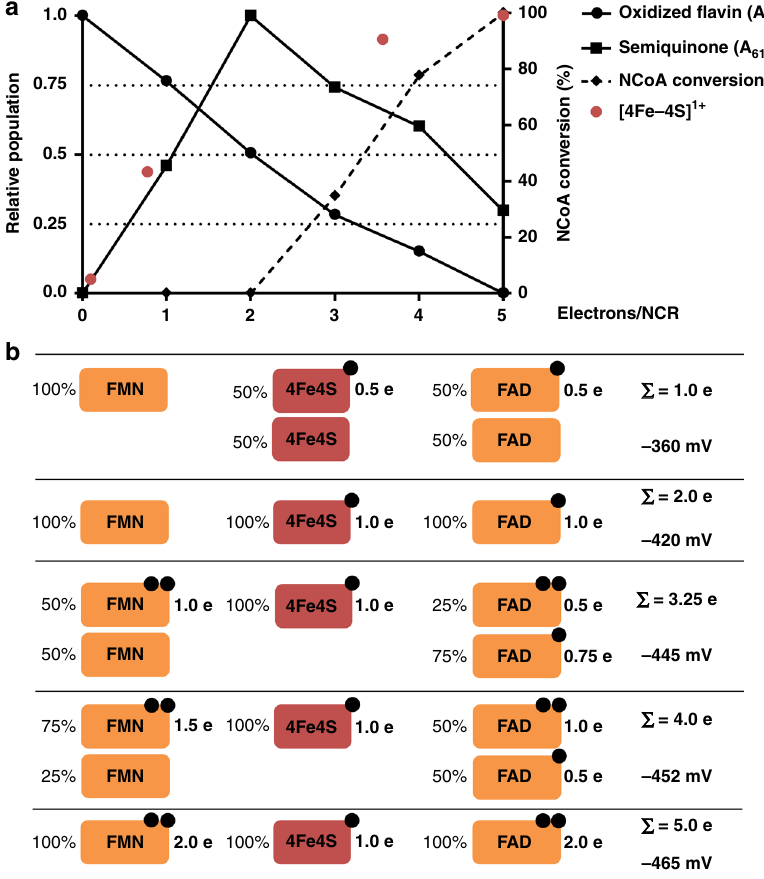
Fig. 7 Summary of redox titration experiments. a Relative populations of oxidized fl avins, neutral SQ, [4Fe – 4S] 1 + cluster and extent of NCoA reduction after addition of up to fi ve electron equivalents to oxidized NCR. Species were determined by UV/vis spectroscopy at 444 nm (oxidized fl avins), and 610 nm (neutral SQ); [4Fe – 4S] 1 + cluster by EPR spectroscopy. b Cartoon summarizing reduction of individual NCR cofactors depending on the number of electron equivalents added/redox potential. Source data are provided as a Source Data fi